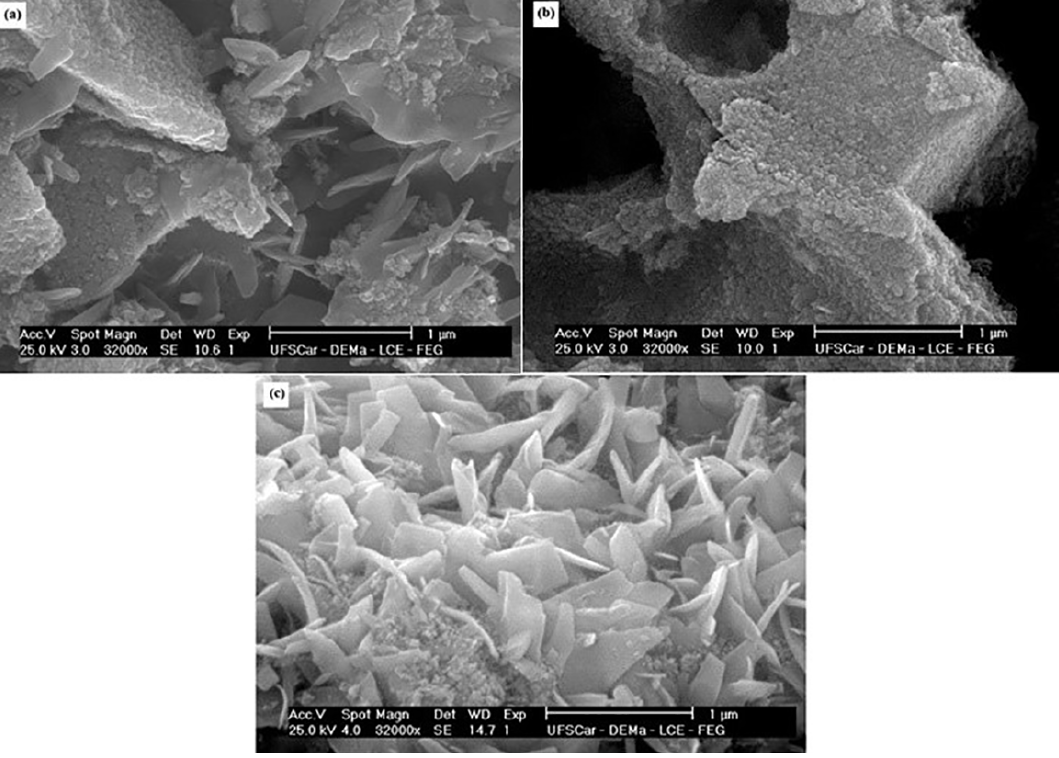
Mn O; 0.975 0.025